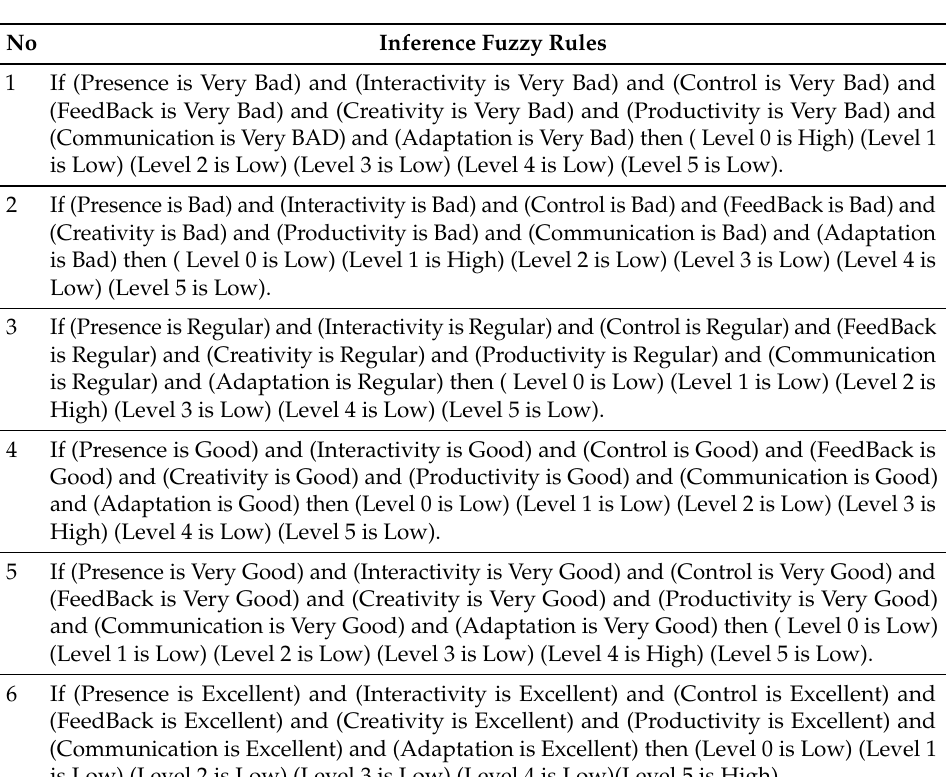
Table 1. Inference Fuzzy Rules of the Empirical